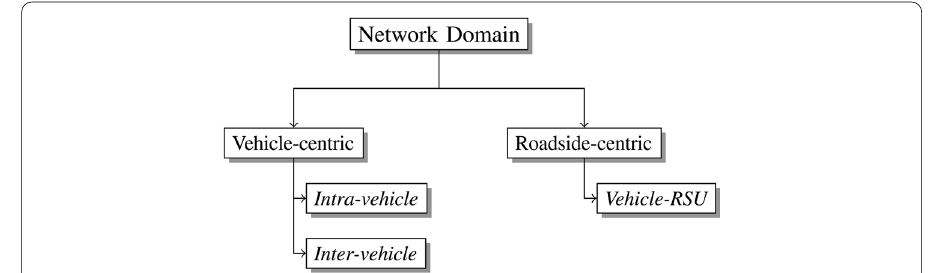
Fig. 14 Network domain class in expanded